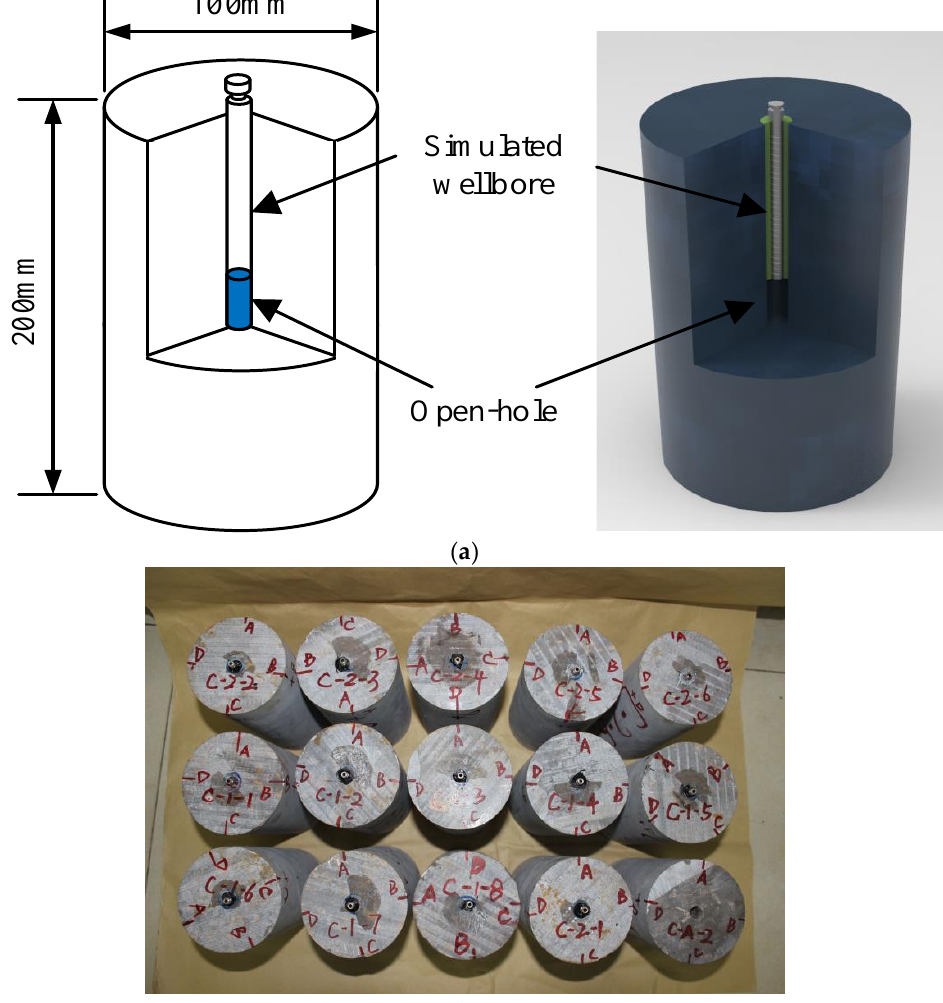
Figure 1. Sample design for hydraulic fracturing: ( a ) Dimensions of sample; ( b ) manufactured sample.